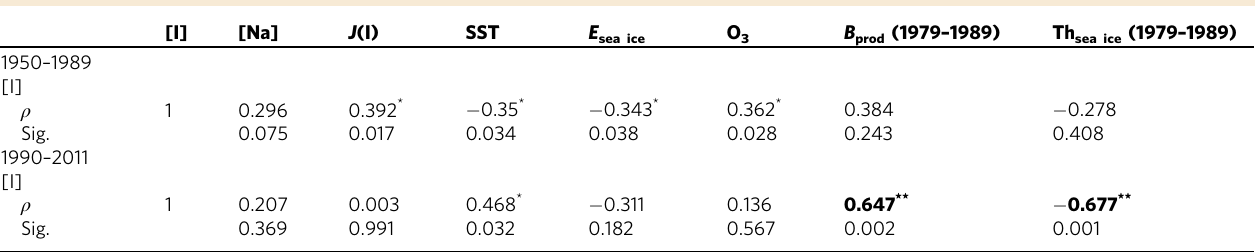
Fig. 1 Time series of geochemical elements in the Renland ice-core during the Industrial Period. a Iodine [I] concentration and standard deviation, b positive (red) and negative (blue) variation of iodine depositional fl uxes J [I] with respect to the 1750 – 2010 average and c sodium [Na] concentrations and standard deviation from Renland ice core (black and red lines represent the 5-samp. running averages for iodine and sodium, respectively); d Arctic sea ice extent reconstruction (thin line from Kinnard et al. 54 and thick line from Rienecker et al. 55 ). The shaded area represents the period 1950 – 2011 shown in Fig. 2 Table 1 Correlation coef fi cients between iodine concentration and other